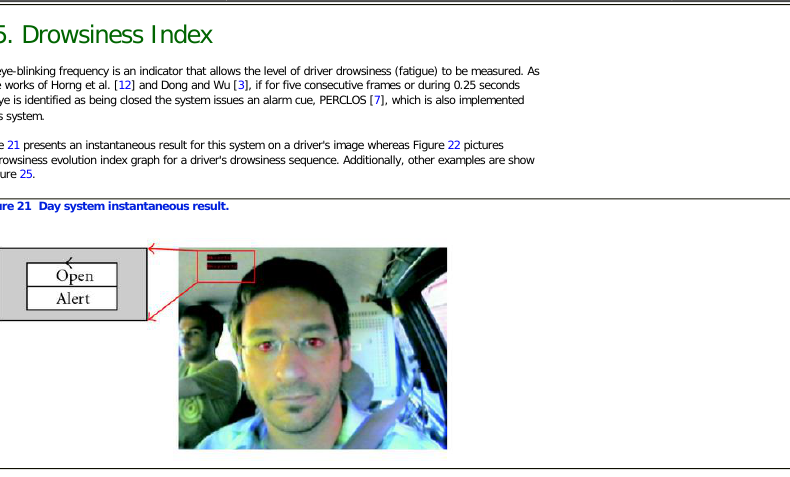
Figure 22 Drowsiness index graph for a 900-frame sequence of a drowsy driver: (a) Perclos, (b) Horng-Dong and Wu